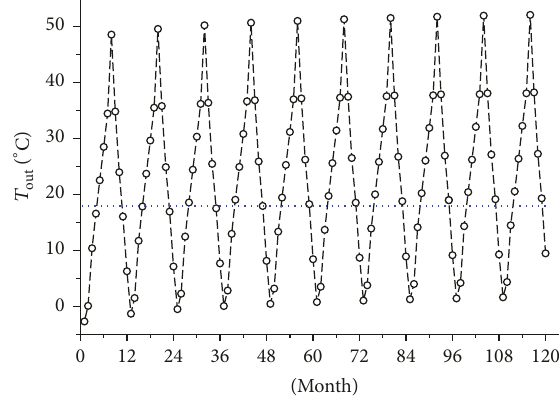
Figure 5: Monthly average outlet fluid